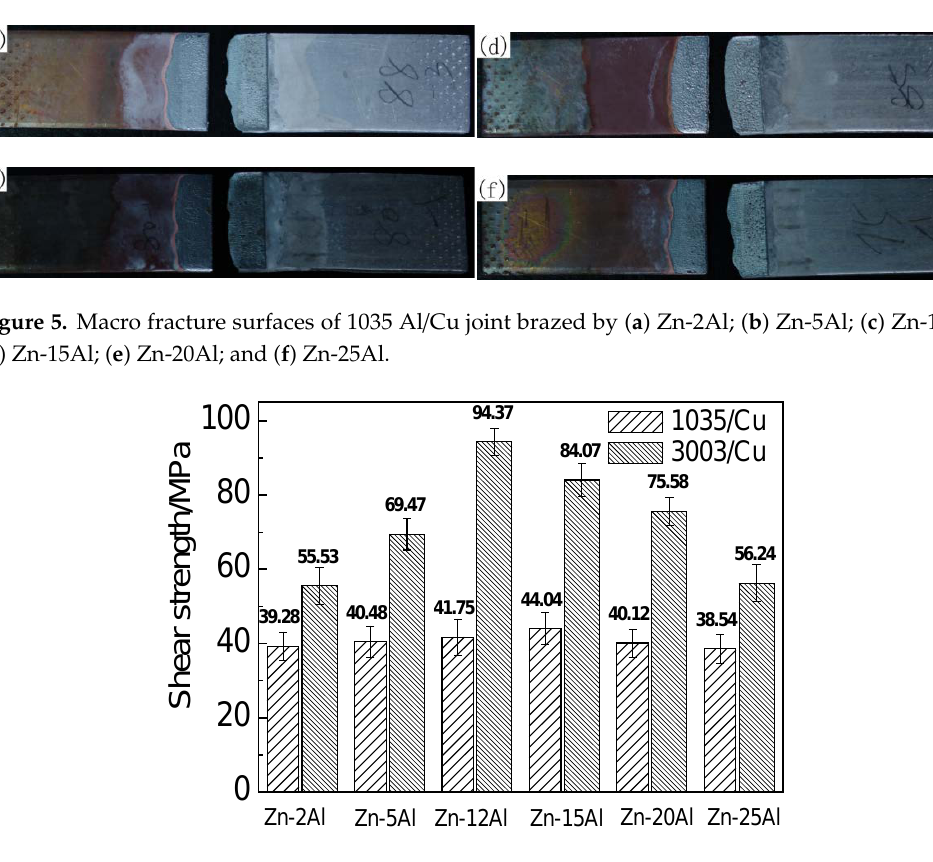
Figure 5. Macro fracture surfaces of 1035 Al/Cu joint brazed by ( a ) Zn-2Al; ( b ) Zn-5Al; ( c ) Zn-12Al; ( d ) Zn-15Al; ( e ) Zn-20Al; and ( f ) Zn-25Al.